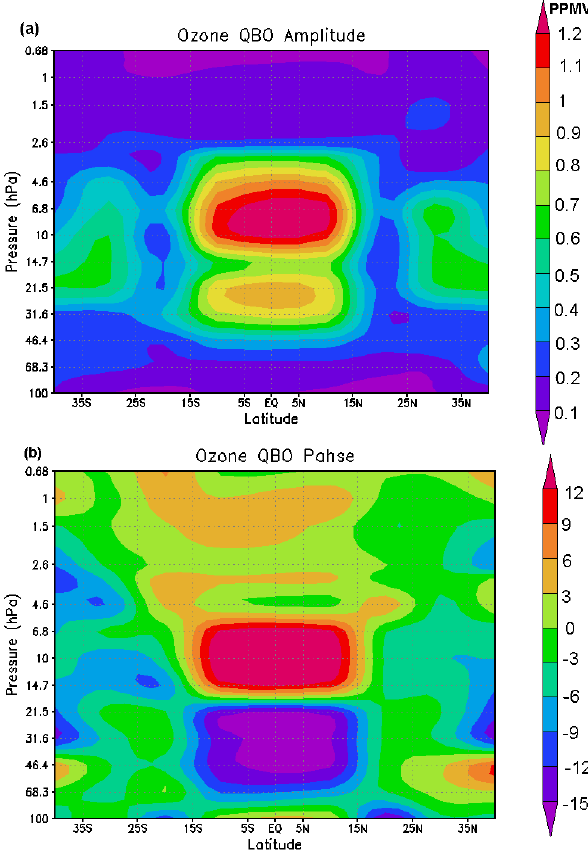
Fig. 7. Latitude-height structure of ozone QBO (a) Amplitude (b) Phase.